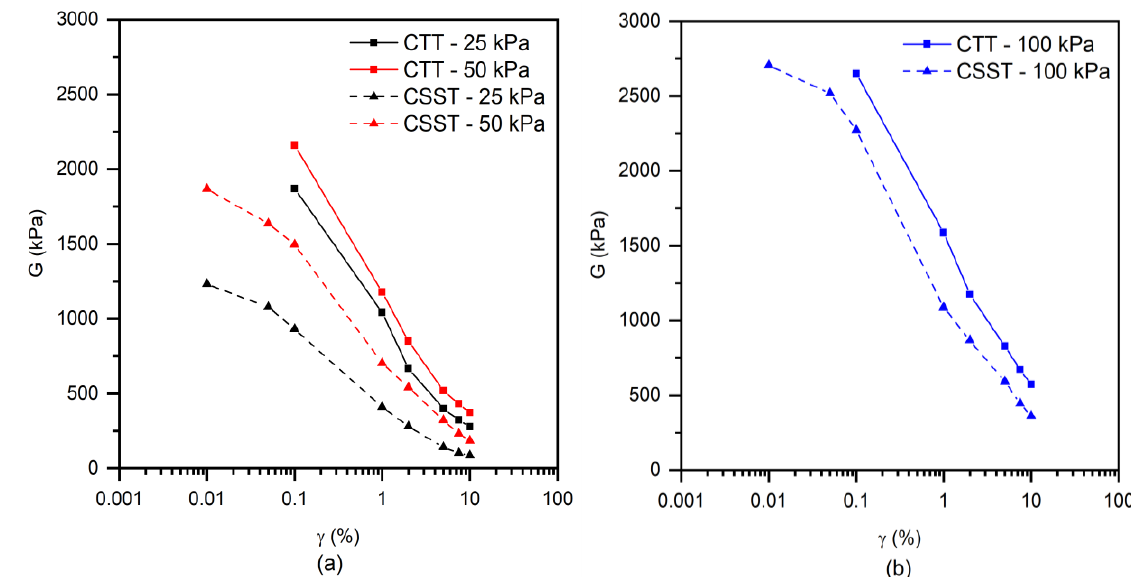
Figure 5. Backbone curves at different consolidation stresses from ( a ) CTTs and ( b ) CSSTs. tests.